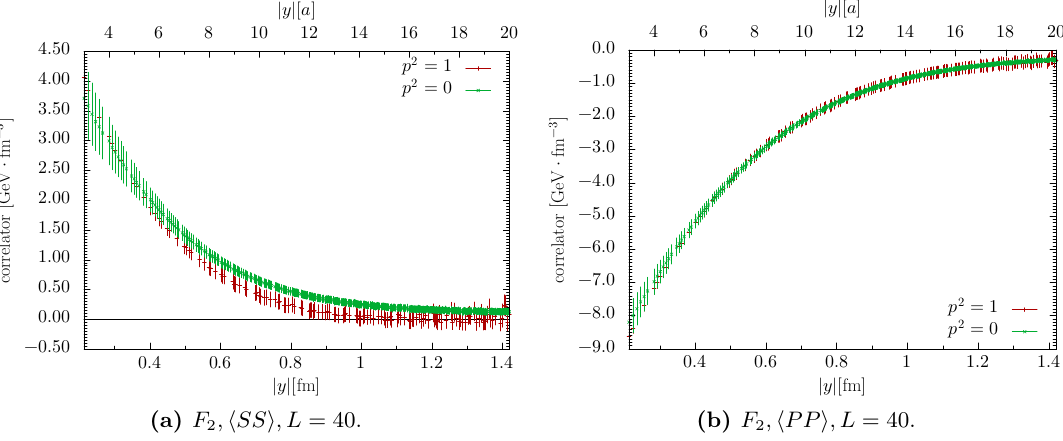
SS and PP with di(cid:11)erent pion momenta. We h i h i 437 MeV. (cid:25)